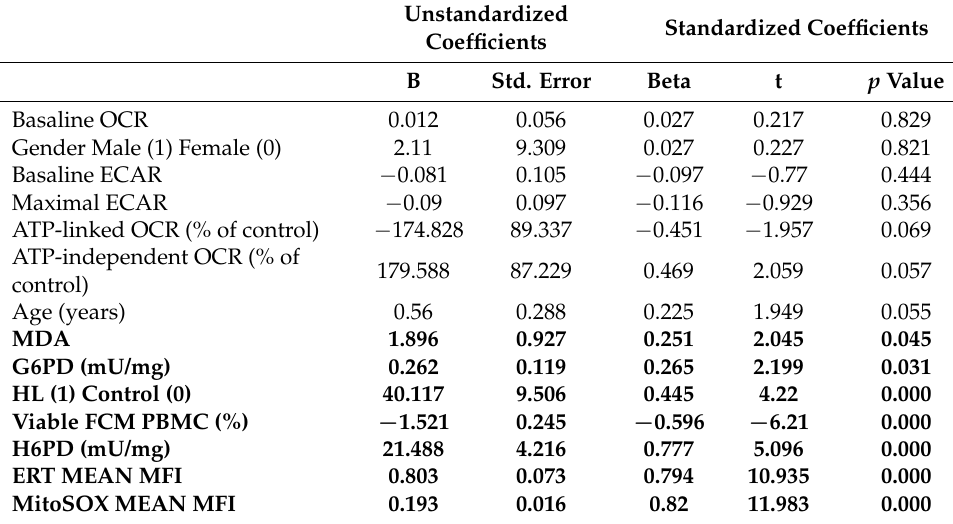
Table 2. Prediction of 2-NBDG uptake by univariate regression